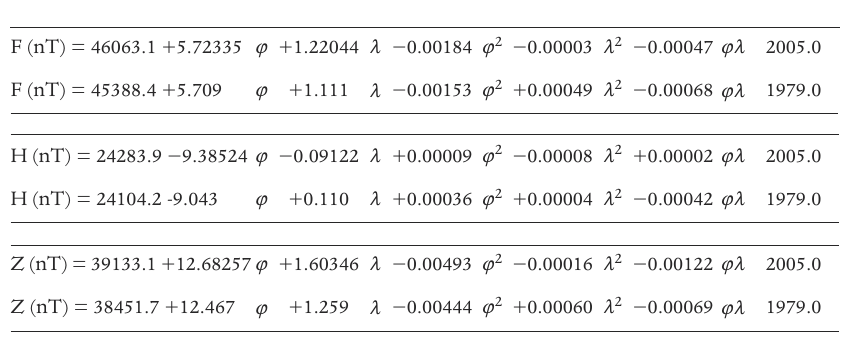
Table 2. Coefficients of the Italian Geomagnetic Reference Field (ItGRF) for the epochs indicated at the end of each row, for the magnetic elements F , H , Z . Latitude { and longitude m are referred to 42°N and 12°E, respectively, with values expressed in degrees. F , H , Z are in